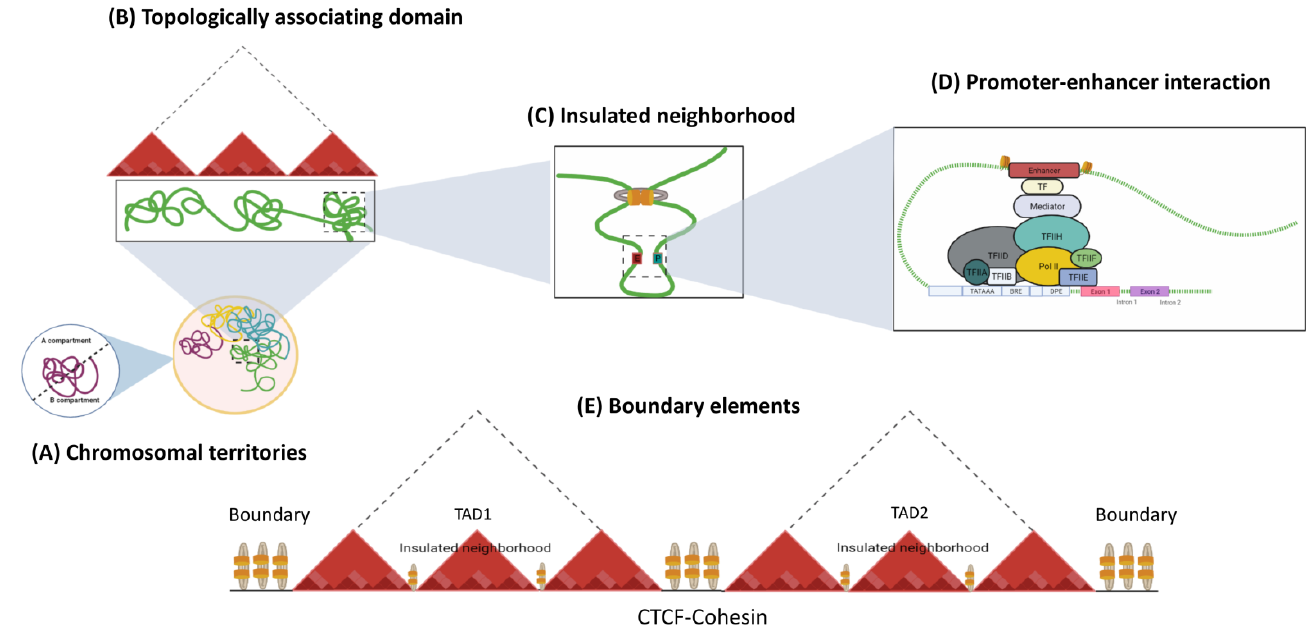
Figure 2. Hierarchical organization of genome. The nucleus in mammalian cells is structured into chromosomes, which have a non-random distribution. ( A ) In interphase, each chromosome is located into discrete sub-nuclear domains called chromosomal territories (CT). Within interphase chromosomes, chromatin folds into ( B ) TADs, which are areas where frequent interactions occur between specific CREs and genes at the local level. ( C ) Insulated neighborhoods are loops constructed by CTCF/cohesin-bound anchors harboring genes and CREs that control gene expression. ( D ) The interaction between CTCF and cohesin facilitates the formation of chromatin loops, where Transcription factors (TF), such as pioneering TFs, bind to enhancers, allowing for the recruitment of the Mediator complex, which further assembles basic transcription machineries at the gene promoter and activates transcription. ( E ) The regions bordering TADs or TAD boundaries regulate gene expression by restricting interactions between adjacent CREs from distinct TADs, avoiding incorrect interactions.